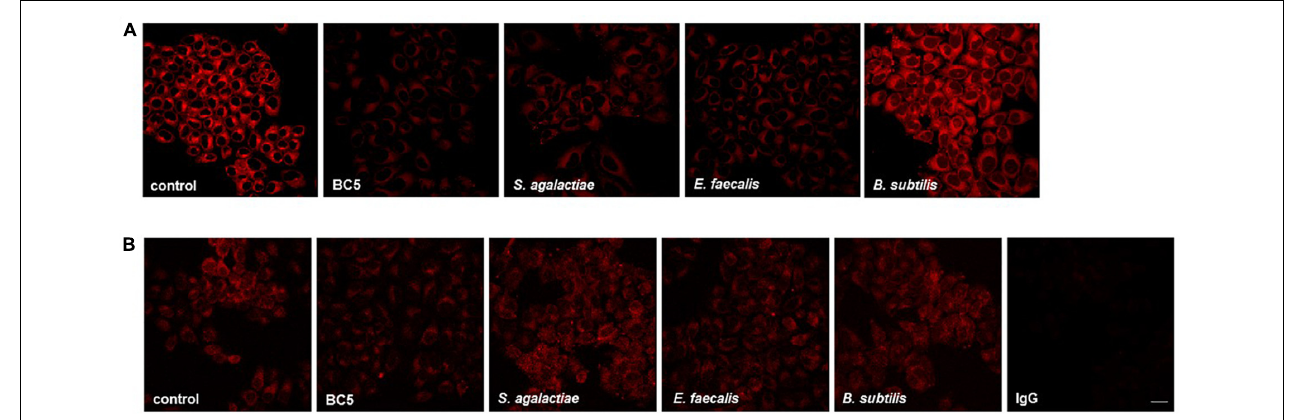
FIGURE 3 | Membrane lipid organization and α 5 integrin exposure on HeLa cells incubated with microorganisms. (A) HeLa cells were incubated with L. crispatus BC5, S. agalactiae , E. faecalis, or B. subtilis for 1 h and then stained with NR. (B) HeLa cells were incubated with L. crispatus BC5, S. agalactiae , E. faecalis , B. subtilis for 1 h and then stained for α 5 integrin subunit. IgG represents specificity staining control. Representative micrographs are shown. Experiments were repeated at least three times with similar results. Bar: 20 µ